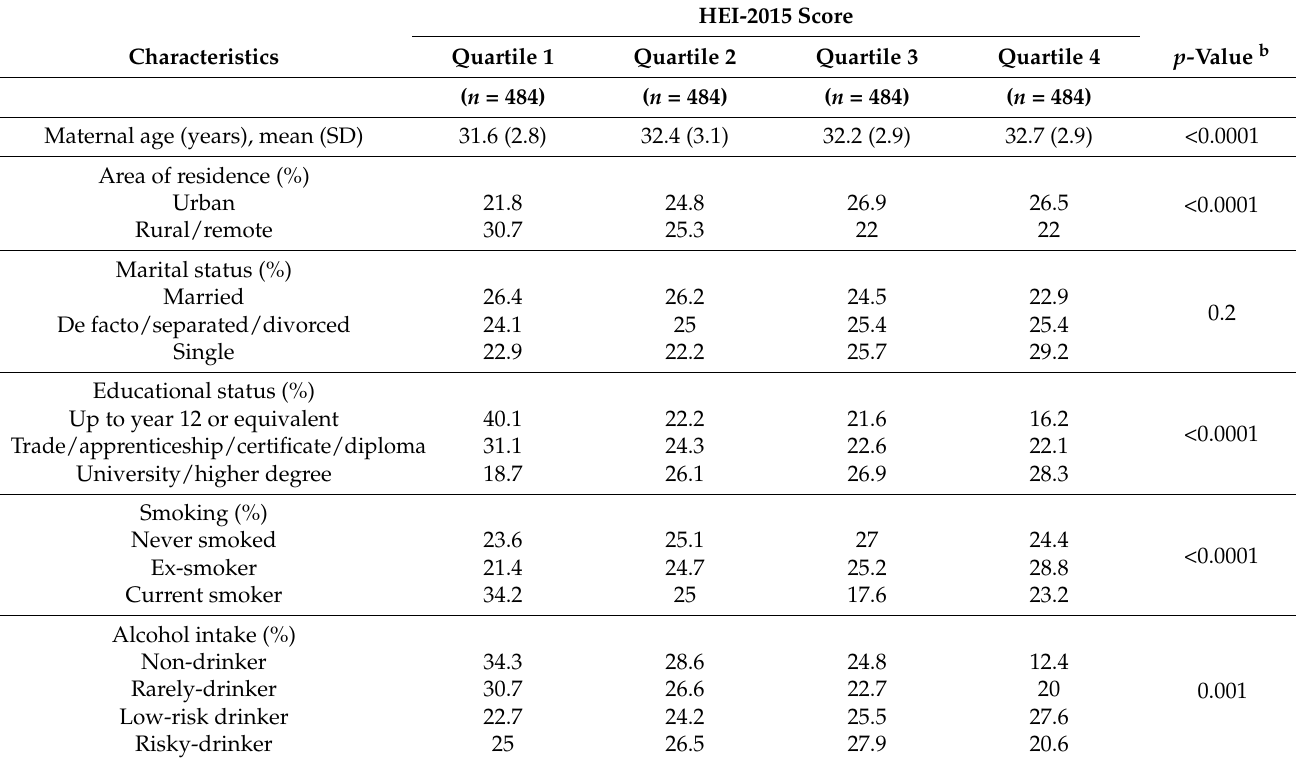
Table 2. Maternal characteristics according to HEI-2015 score ( n = 1936 mothers) a .